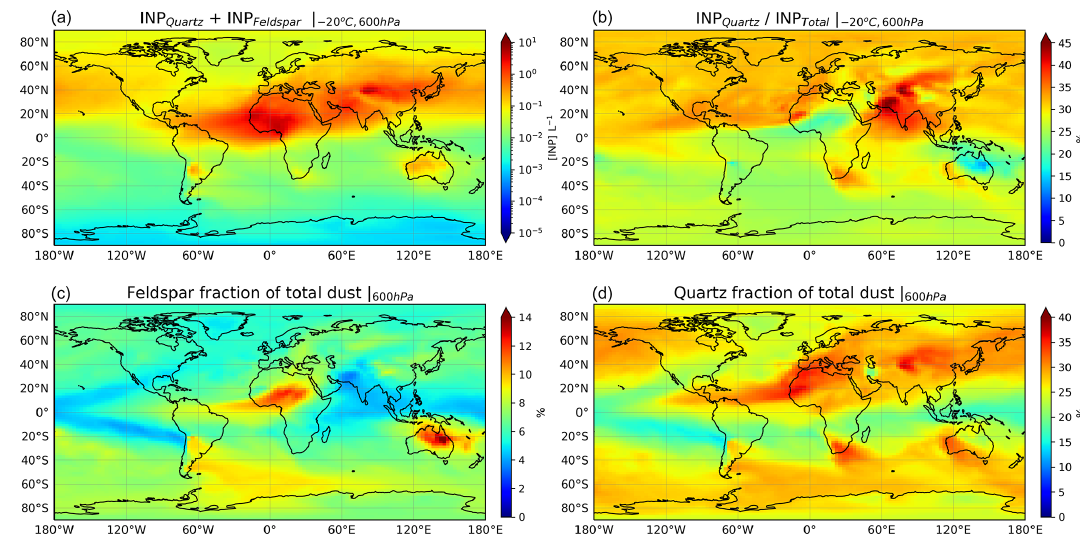
Figure 5. Annual-mean distributions calculated by TM4-ECPL for the year 2015 of (a) INP concentrations for an activation temperature of − 20 ◦ C based on K-feldspar and quartz at a pressure level of 600hPa, (b) ratio of INPs from quartz over total INPs from dust (K-feldspar and quartz) at the same conditions, ( c and d ) mass ratios of feldspars (c) and quartz (d) in percentages over total dust mass at 600hPa.